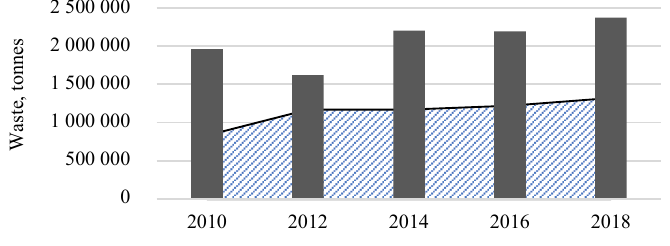
Fig. 1. Amount of generated and recycled textile waste in EU from 2010-2018